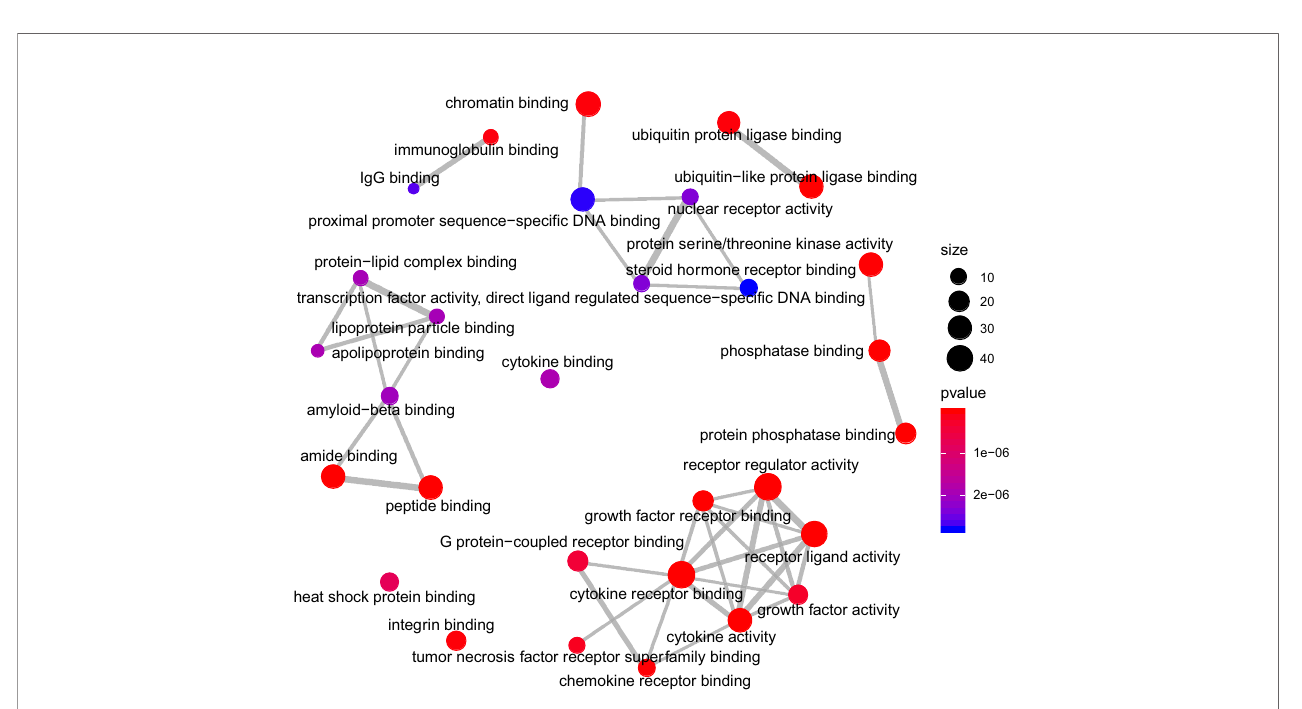
FIGURE 5 | Network of enrichment analysis of GO molecular function terms. The size of the node represents the number of genes involved in the enrichment pathway, and the color from blue to red indicates the P-value from small to